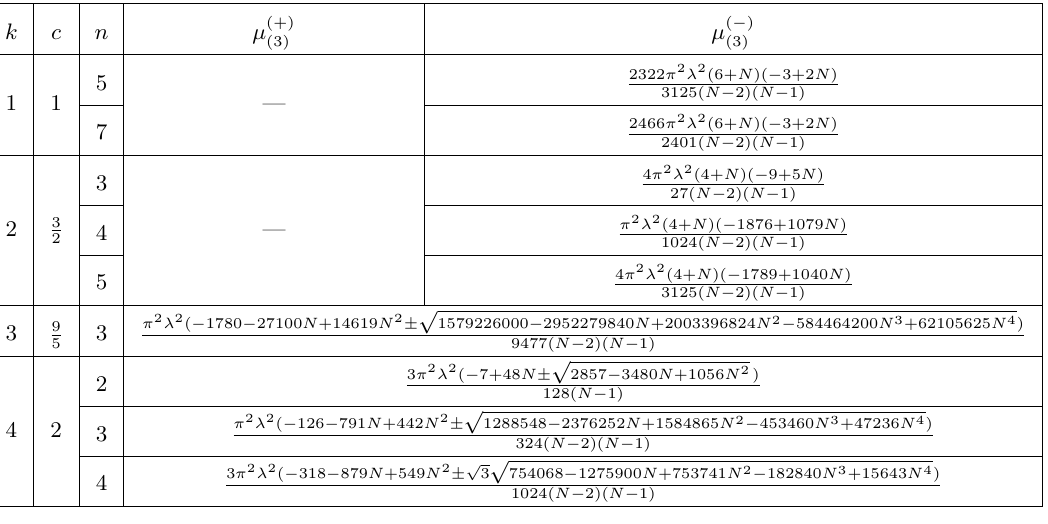
Table 4 . The anomalous dimensions of the spin-3 currents of symmetric orbifolds with seed central charge 1 ≤ c ≤ 2 . When c = 1 or 3 / 2 one of the spin-3 currents becomes null and the anomalous dimension of the unnormalized current vanishes. The non-vanishing values of the anomalous di- mensions are real and positive for all N ≥ n